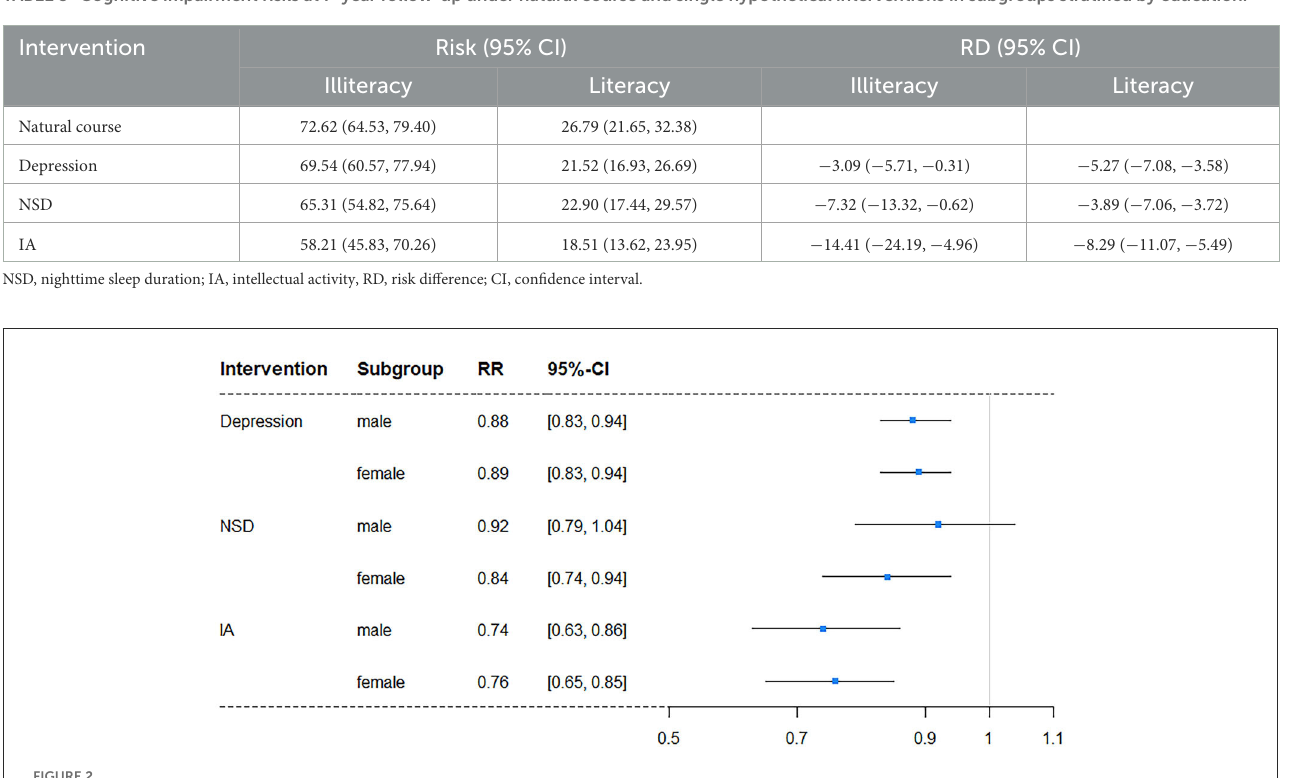
FIGURE2 Forest plot of RR for depression risk in subgroups stratified by gender (NSD, nighttime sleep duration; IA, intellectual activity, RR, risk ratio; CI, confidence interval).